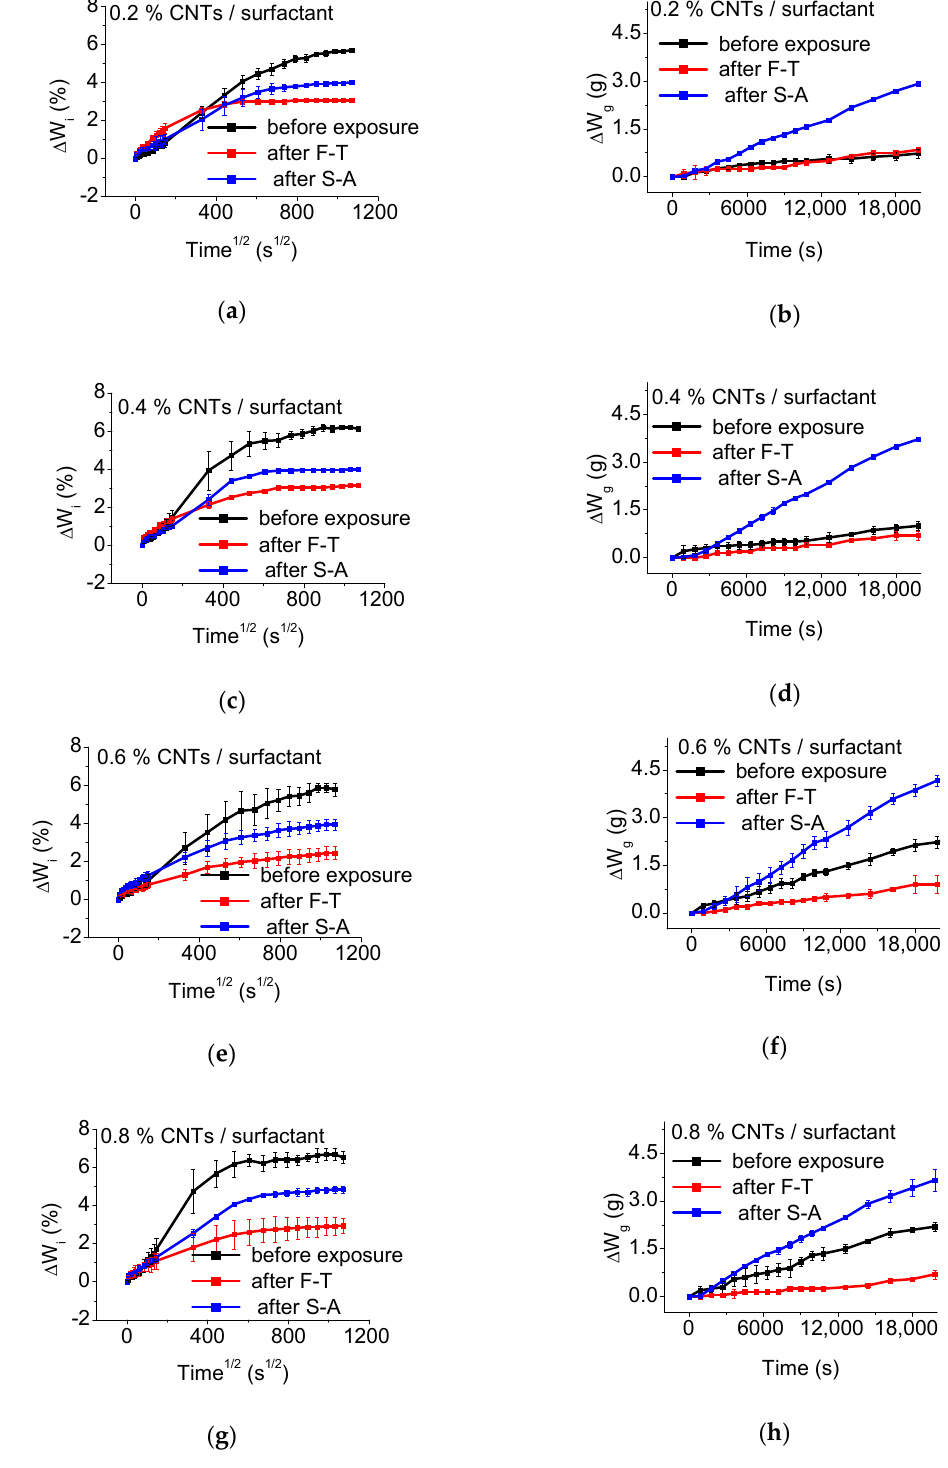
Figure11. E ff ectofexposurestateonthewaterabsorption( a , c , e , g )andgaspermeability( b , d , f , h )profiles Figure 11. Effect of exposure state on the water absorption ( a , c , e , g ) and gas permeability ( b , d , f , h ) of mortars with: ( a , b ) 0.2, ( c , d ) 0.4, ( e , f ) 0.6, and ( g , h ) 0.8 wt.% CNT contents, prepared using surfactant profiles of mortars with: ( a ), ( b ) 0.2, ( c ), ( d ) 0.4, ( e ), ( f ) 0.6, and ( g ), ( h ) 0.8 wt.% CNT contents, prepared as using surfactant as dispersant. Table 2. Diffusion coefficient, D m and relative weight gain at saturation, ΔW s , as a function of CNT content, dispersive medium and exposure state.